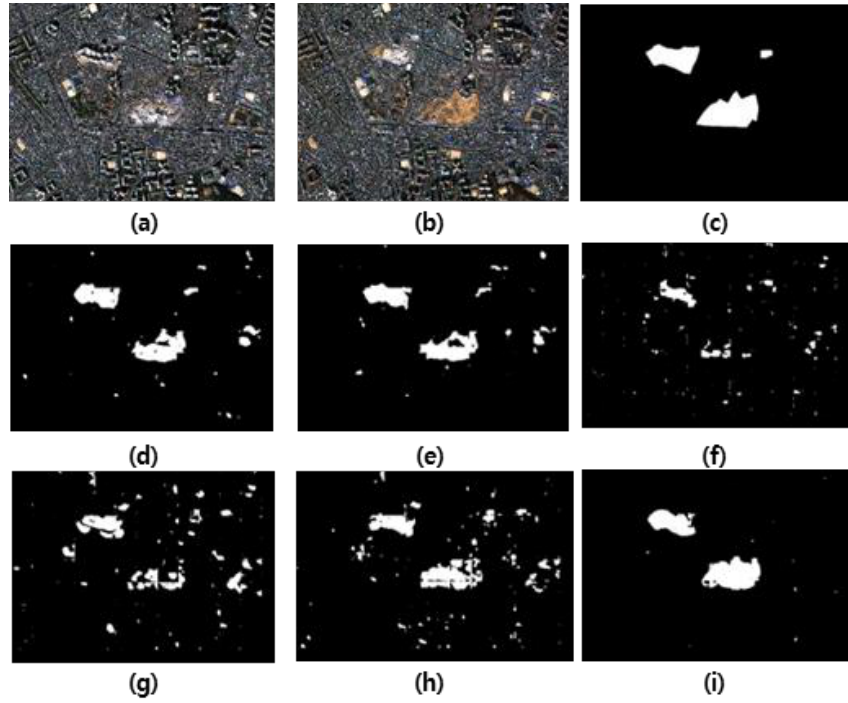
Figure 13. Changed detection maps of the proposed and conventional algorithms for “Test area 1” for the reverse input order: ( a ) Image P; ( b ) Image C; ( c ) Ground truth; ( d ) DI + UNet; ( e ) DI + ATTUNet; ( f ) JF + UNet; ( g ) JF + ATTUNet; ( h ) Modified-UNet++; ( i ) Proposed bilateral dissimilarity U-Net.